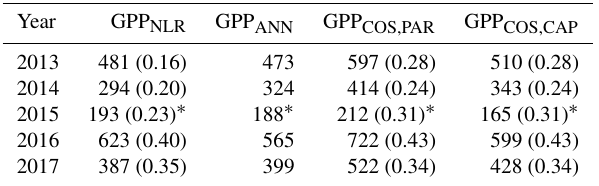
Table 2. Cumulative GPP (gCm − 2 ) over May–July with different GPP estimates. All sums are calculated from the same data cover- age, and the fraction of gap-filled flux data (CO 2 flux for GPP NLR , COS flux for GPP COS,PAR and GPP COS,CAP ) is presented in paren- theses. GPP ANN does not include gap-filled NEE data since it is based on meteorological variables. ∗ In 2015, the cumulative sum covers only